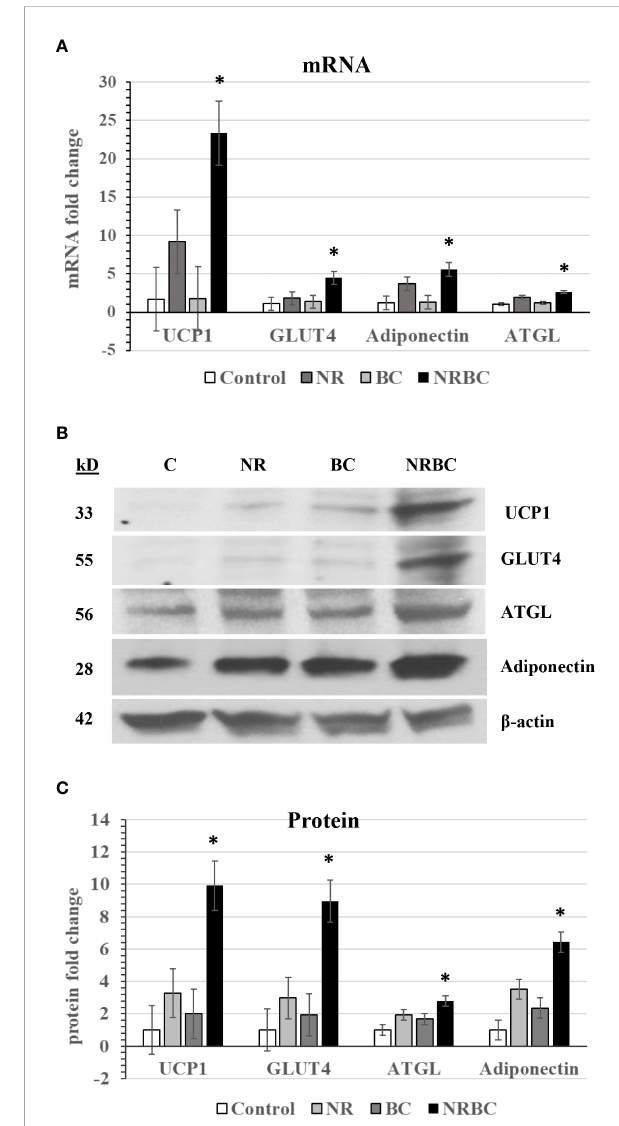
FIGURE 2 NR and BC synergistically induce metabolism genes (A) mRNA levels (B) Western Blots of Protein levels (C) Protein levels were measured with b -actin as loading control. Adipocytes from three or more donors with obesity were treated for seven days. mRNA data are expressed as least squares means ± standard error. Synergy for mRNA was calculated as: sum of differences ((NR- Control) + (BC - Control)) vs (NRBC - Control). *p < 0.05 for synergy. NR, Naringenin; BC, beta carotene; NRBC, naringenin and beta carotene. NRBC upregulated protein levels of PPAR a , PPAR g , PGC-1 a , and NAMPT three to six-fold (Figure 3, p<0.001) without comparable increases in mRNA levels. Uncropped Western blots are shown in Supplemental Figure 2. PPAR a , PPAR g , and PGC-1 a proteins have a short half-life and are rapidly degraded by ubiquitin-proteosome systems (55 – 57). Inhibition of degradation increases protein levels and target gene expression (58). The binding of ligands and coactivators can in fl uence the turnover rates of PPAR a and PPAR g (59, 60). Treatment with NR alone did not upregulate protein levels, indicating that RXR ligand is required in addition to PPAR ligand for protein upregulation. The